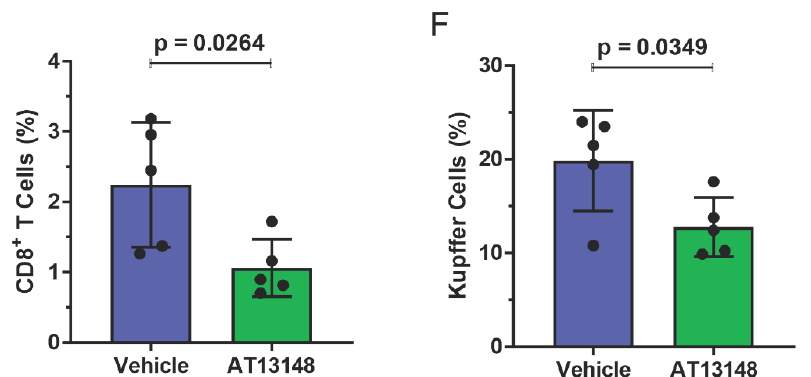
Figure 7. ROCK inhibitor AT13148 lowered circulating platelet and lymphocyte numbers, and reduced immune cell recruitment to livers following acute DEN treatment. ROCK1wt mice were treated with 40 mg/kg AT13148 or vehicle 3 × per week via oral gavage for 10 days, then injected with 100 mg/kg DEN intraperitoneally 3 days prior to sacrifice to induce acute liver damage. Flow cytometry analysis of circulating ( A ) platelets and ( B ) lymphocytes in vehicle ( n = 5) and AT13148 ( n = 4) treated mice. Liver cell suspensions were analyzed by flow cytometry to determine the relative proportions of ( C ) dendritic cells, ( D ) natural killer (NK) cells, ( E ) CD8+ T cells and ( F ) Kupffer cells from vehicle and AT13148 treated mice ( n = 5). Means ± standard deviation. Unpaired Student’s t-test, p values less than 0.05 indicated in bold